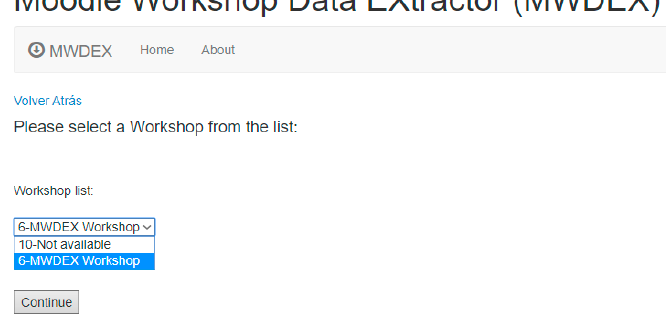
Figure 6. MWDEX screen for workshop selection.